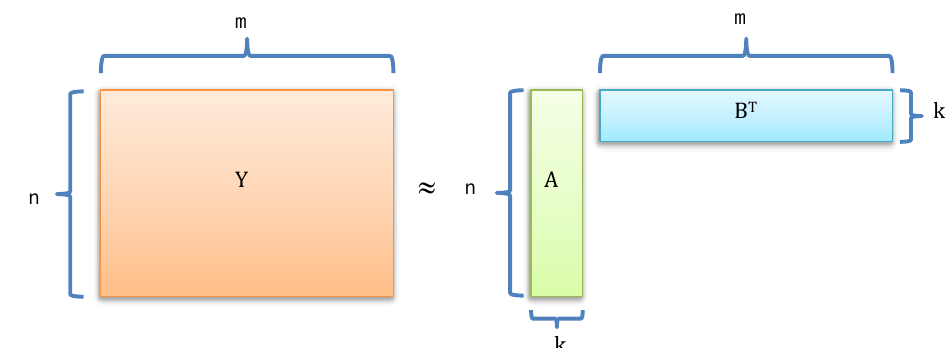
Figure 9. The flowchart of DTI identification methods based on matrix factorization.